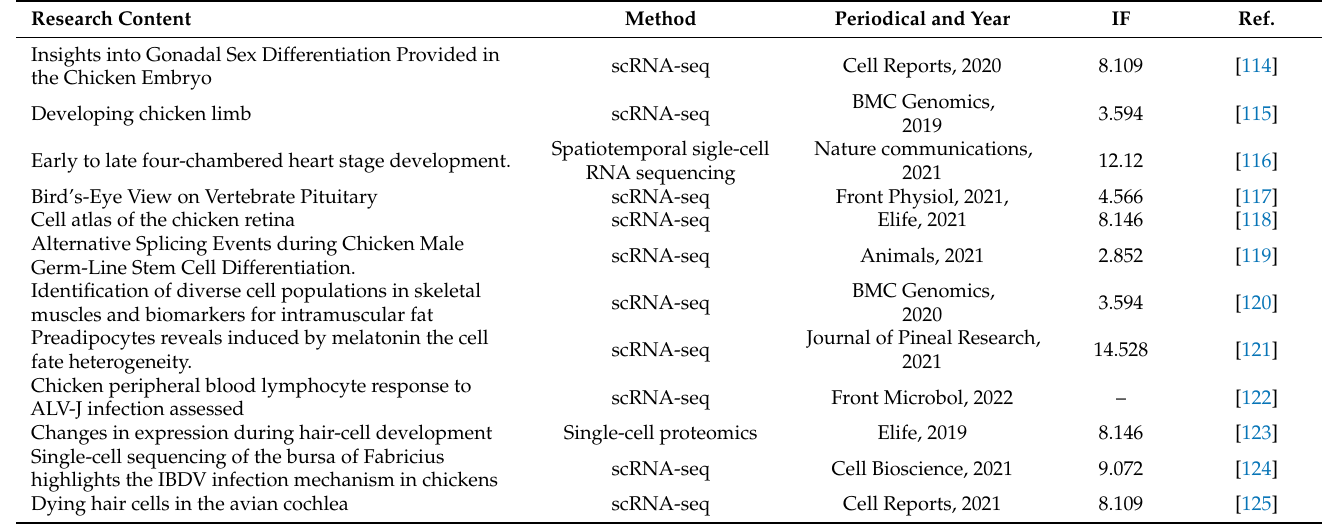
Table 11. Application of SCS in poultry science in the past three